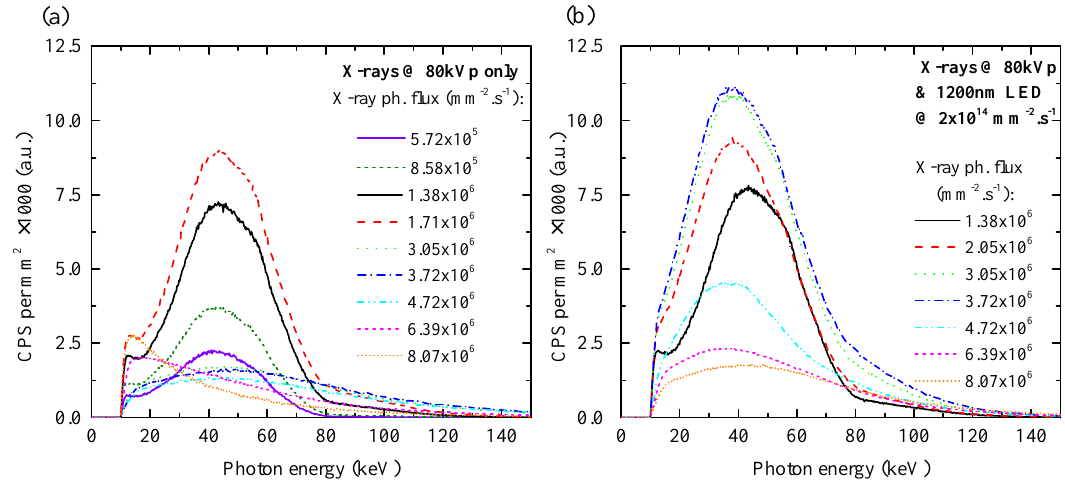
Figure 4. Spectra measured on the central pixel of Sample 2 under X-rays only ( a ) and under X-rays and simultaneous illumination with the 1200-nm LED with photon flux 2 × 10 14 mm − 2 · s − 1 ( b ). The X-ray tube was biased at 80 kVp. The photon energy was calibrated using a 241 Am gamma source.